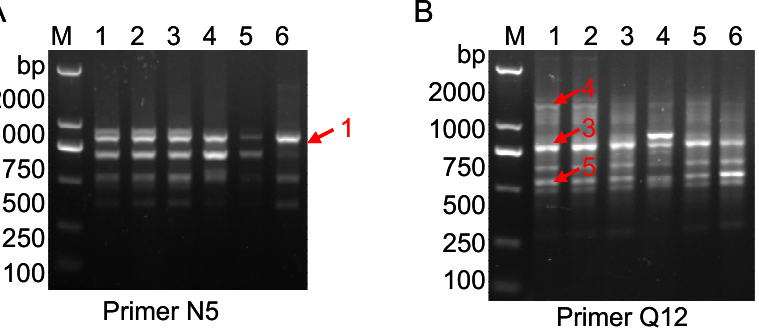
Figure 2. Amplification and recovery of improved random amplified polymorphic DNA (RAPD) fragments. Improve RAPD amplification from DNA samples of G. jasminoides Ellis var. grandiflora Nakai which listed in Table 1 (Nos. 1~6). ( A ) The primer SBC-N5 (N5); ( B ) The primers SBC-Q12 (Q12). The red arrows indicate bands before cut. Lane M indicates the DNA molecular weight marker DL2000 with the fragment size (bp) 2000, 1000, 750, 500, 250, 100.